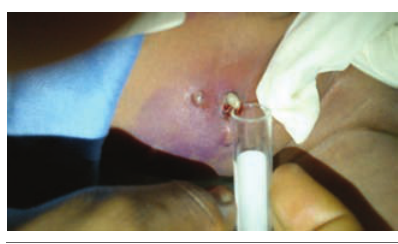
Figure 2. Larva extruding from one of the